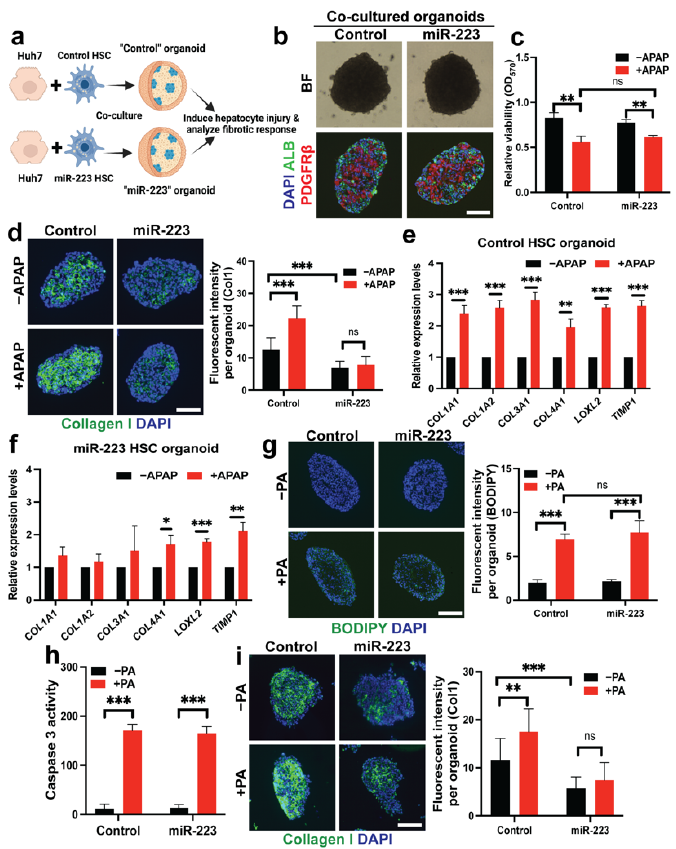
Figure 6. miR-223 suppresses collagen production in injury models of human hepatic organoids. ( a ) Schematic representation of experimental design to generate co-cultured organoids with hepatoma cells, Huh7, and primary HSCs (pHSCs) with or without miR-223 overexpression. ( b ) Representative brightfield (BF) and fluorescent images of co-cultured organoids containing hepatoma cells (ALB + ) and pHSC (PDGFR β + ). ( c ) Viability of hepatic organoids with or without APAP treatment as determined by MTT assay. ( d ) Representative fluorescent images of hepatic organoids with type I collagen stain in the model of APAP-induced liver injury. ( e , f ) Levels of fibrotic gene transcripts from co-cultured organoids as determined by qRT-PCR. ( g ) BODIPY staining of hepatic organoids after incubation with 300 µ M of palmitic acid (PA) for 48 h. ( h ) Apoptosis of hepatic organoids with or without PA treatment as determined by caspase-3 activity. ( i ) Representative fluorescent images of hepatic organoids with type I collagen stain in the model of PA-induced liver injury. Data presented as the mean ± SD expressed relative to those of untreated organoids (set as 1.0) for qRT-PCR experiments. Quantification of fluorescent levels were calculated from at least 10 random organoids for each group from three independent experiments ( d , g , i ). N = 3–4 replicates from at least two independent experiments ( e , f , h ). Fluorescent images taken at equivalent exposure. Student’s t -test; * = p < 0.05, ** = p < 0.01 and *** = p < 0.001. Scale bars, 100 µ m. APAP: